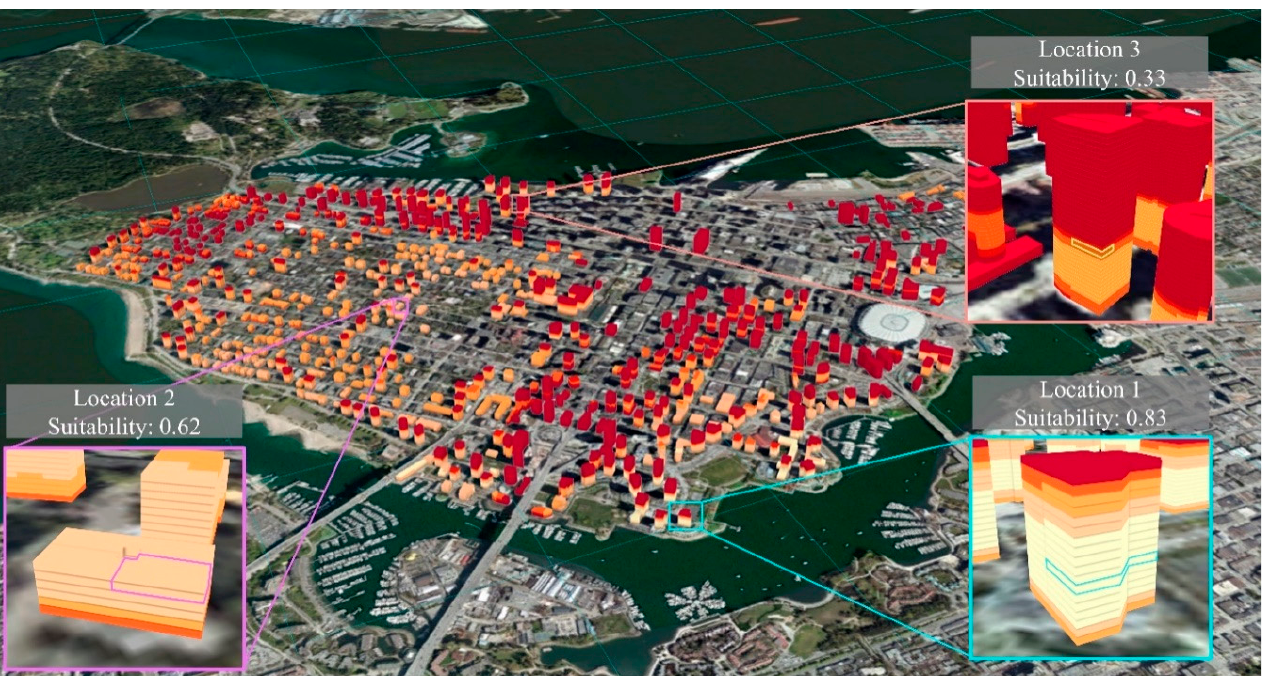
Figure 7. The three residential units selected for the one-at-a-time sensitivity tests with associated suitability scores for Scenario 1.